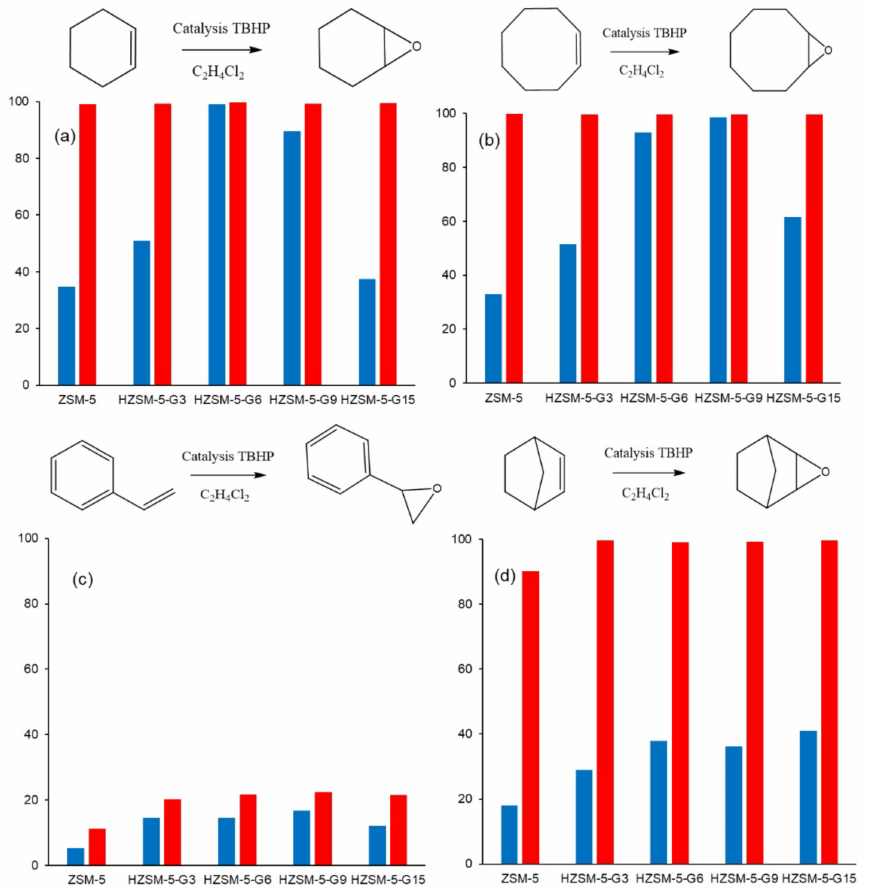
Figure 23. Conversion (%, blue bars) and selectivity (%, red bars) for the epoxidation of cyclohexene ( a ), cyclooctene ( b ), styrene ( c ), and norbornene ( d ), catalyzed by Mo-A-HZSM-5 (Gemini 9 as template) and Mo-A-ZSM-5. Adapted with permission Reference [48]. Copyright (2021) Wiley-VCH